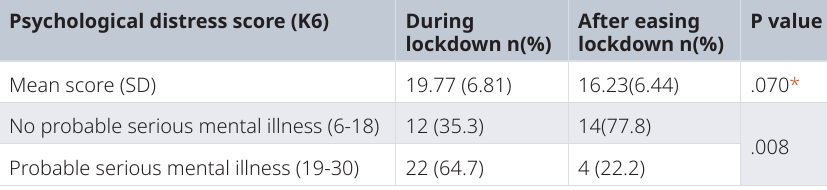
Table 5. Psychological distress in women coming for SAS. Psychological distress score